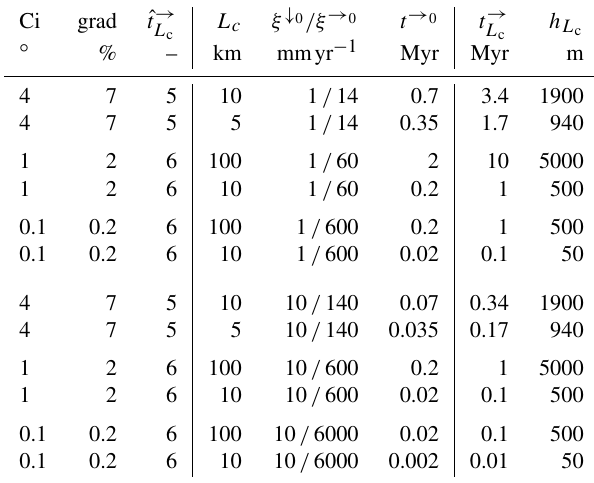
Table 1. Example model parameters and predicted timescales for η = 3 and µ = 3 , and for selected values of dimensionless erosion 2 4 rate Ci and domain length scale L c .